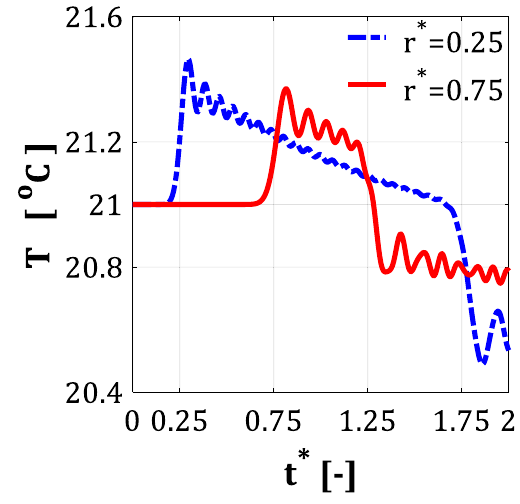
Fig. 7 Temperature–time history at specific non-dimensional radial positions